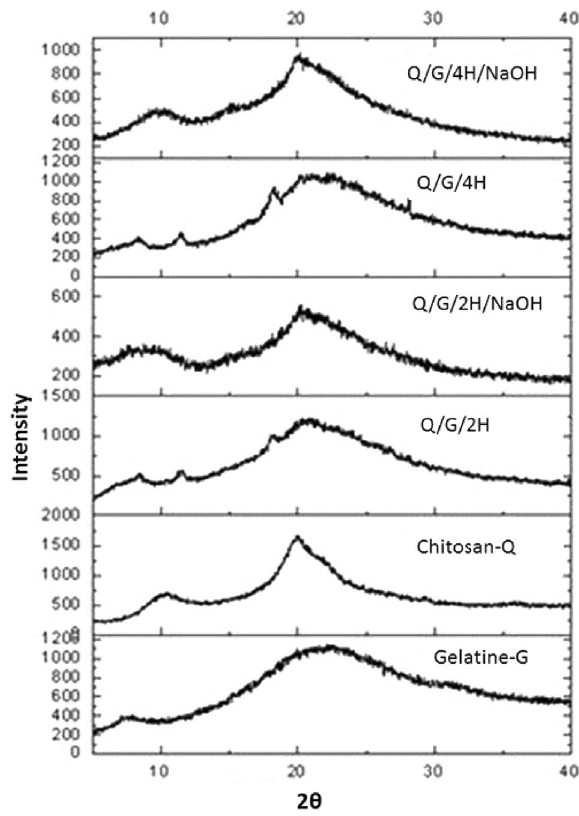
Fig. 1 X-ray diffraction of gelatin powder and chitosan membranes with gelatin and